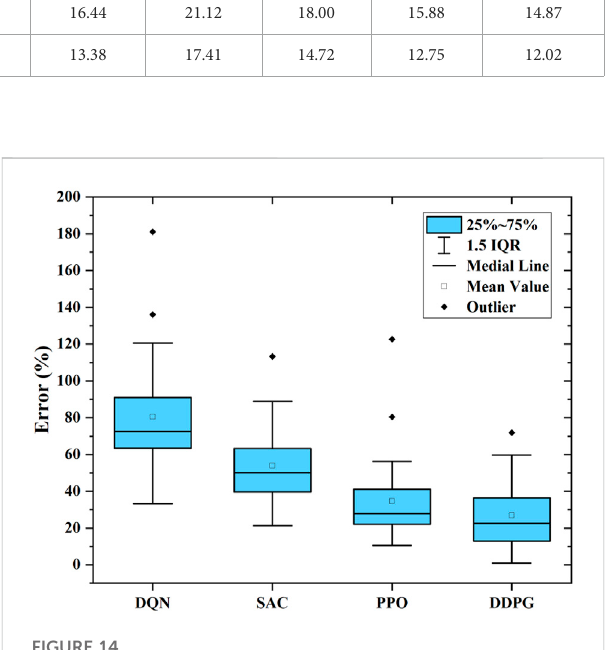
FIGURE 14 Daily operating cost error of the four DRL approaches with the optimal